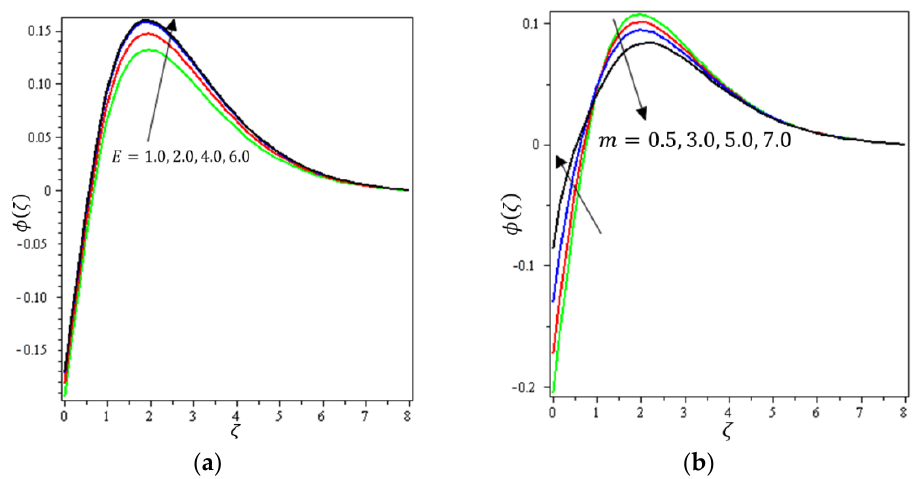
Figure 13. Influence of ( a ) activation energy 𝐸 and ( b ) fitted rate 𝑚 on 𝜙(𝜁) .